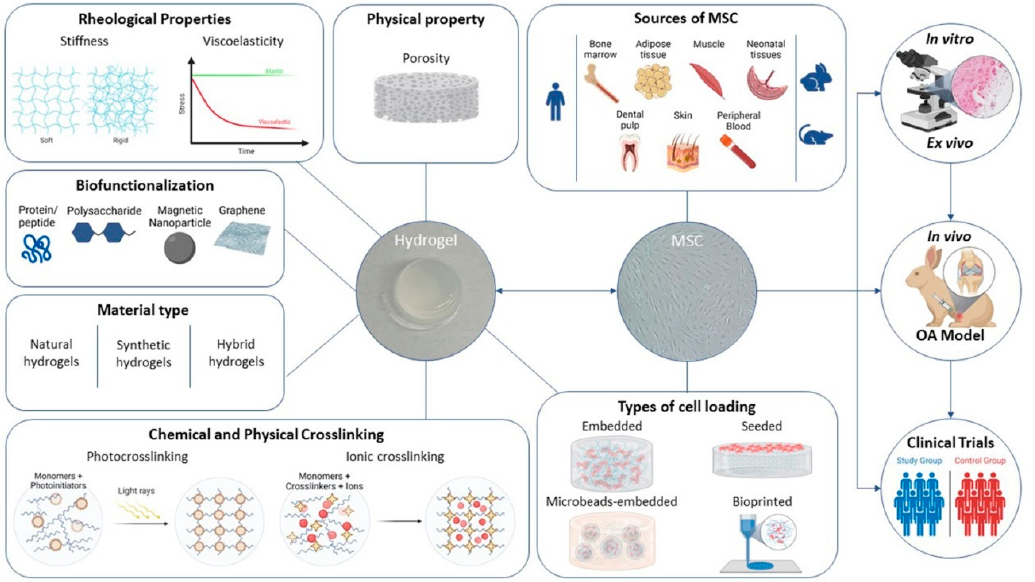
Figure 2. Major items analyzed in the selected studies, used to organize the review content.